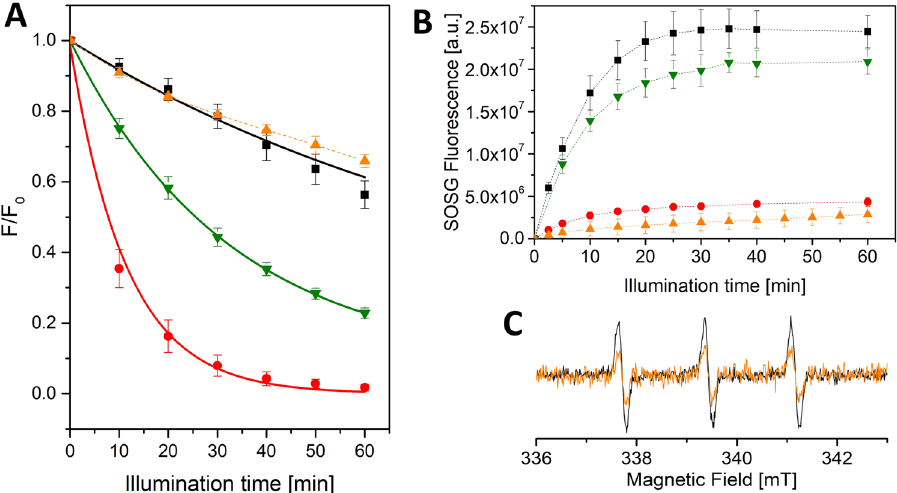
Figure 5. ( A ) Photostability of Chl a (black squares) or Chlide a (green inverted triangles) reconstituted WSCP and of LHCII (orange triangles) in comparison to Chl a in 2% (w/v) OG (red circles). The samples were illuminated with 500 µ mol of photons m − 2 s − 1 for 0–60 min. before fluorescence measurements (excitation at 410 nm, emission F detected at the maximum of the emission spectrum). Emission before illumination: F 0 . Data are expressed as means ( n = 3). Mono-exponential fits are shown as continuous lines (fitting parameters in Table S1), LHCII data were not satisfactorily fit and the connecting line is reported in dash. ( B ) Singlet oxygen production of Chl a (black squares) or Chlide a (green inverted triangles) reconstituted WSCP and LHCII (orange triangles) in comparison to Chl a in 2% (w/v) OG (red circles). The samples were illuminated with 500 µ mol red ( λ > 590 nm) photons m − 2 s − 1 for 0–60 min before SOSG emission detection (excitation 480 nm, emission 530 nm). Data are expressed as means ( n = 3), with the connecting lines in dash. ( C ) Spin-trap EPR measurements of 1 O 2 production in Chl a reconstituted WSCP complexes (black) and LHCII (orange). TEMPO-formation detected after illumination at 150 μ mol of photons m − 2 s − 1 for 60 min. Background signals were